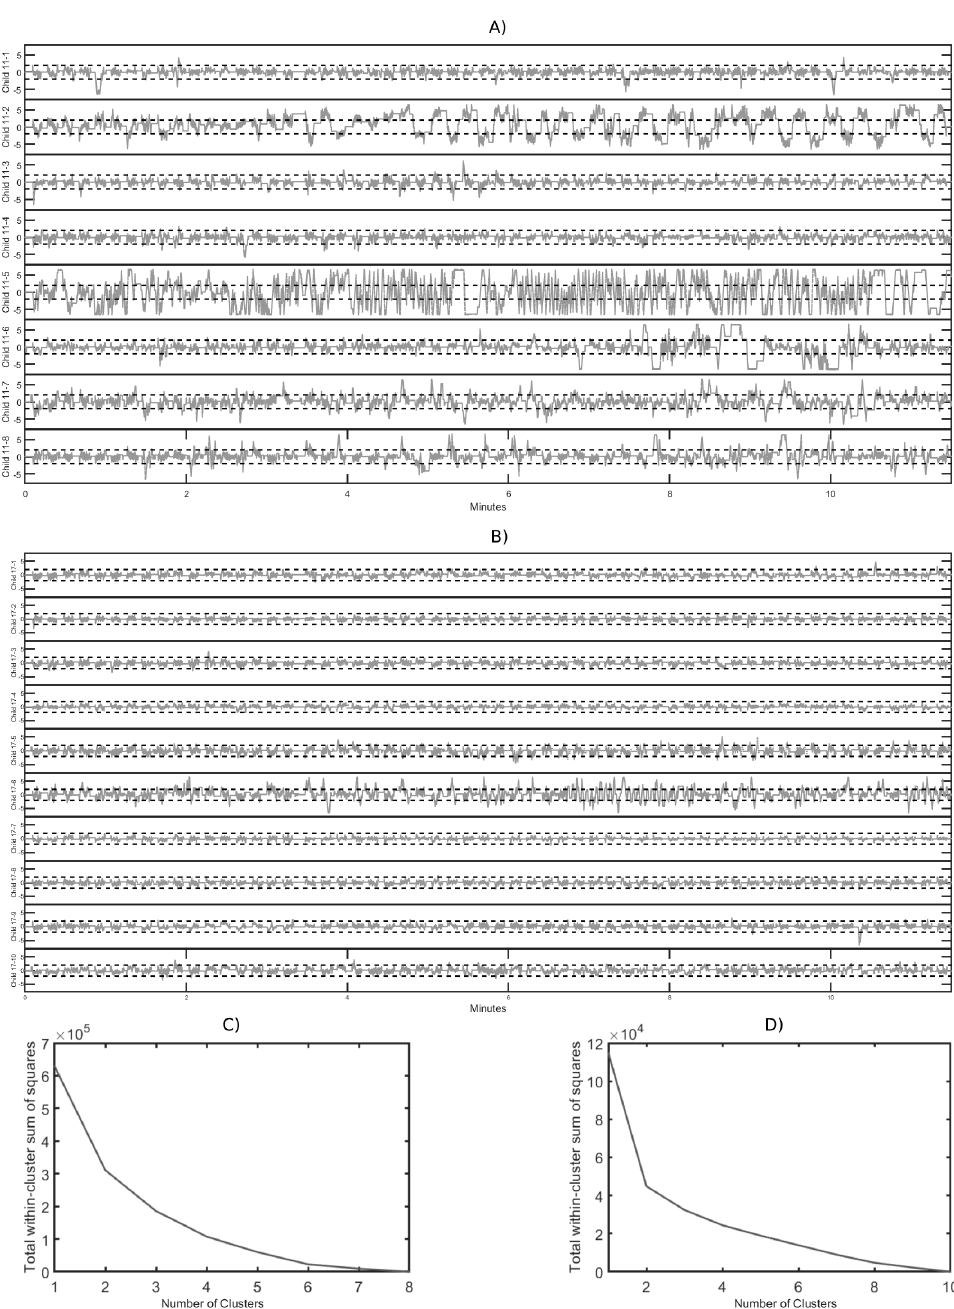
Figure 3. A k -means cluster analysis was performed. ( A ) The error graph over time for 11-year-olds. ( B ) The error graph over time for 17-year-olds. ( C , D ) show the scree plots with the number of clusters for 11-year-olds and 17-year-olds